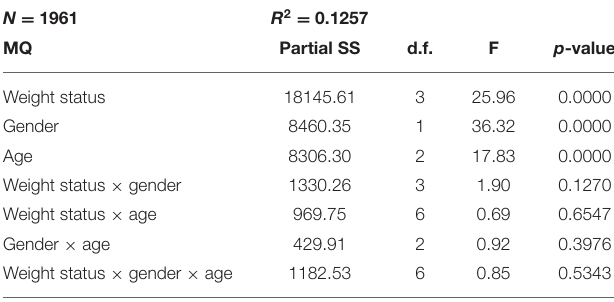
TABLE 6 | Interaction effect of weight status, age, and gender on